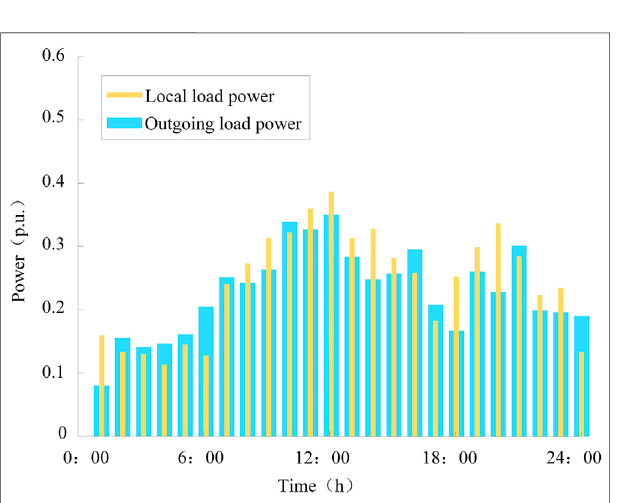
FIGURE 7 | The distribution space of the optimal solution of the upper- layer